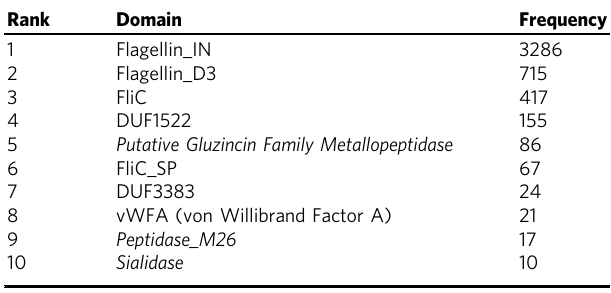
Table 1 Top 10 most frequent protein domains detected within fl agellin hypervariable regions according to the NCBI conserved domain